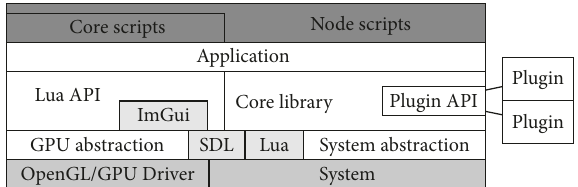
Figure 1: Block diagram of the software. SDL provides most of the platform-dependent functionality; everything except the lowest software layer is completely